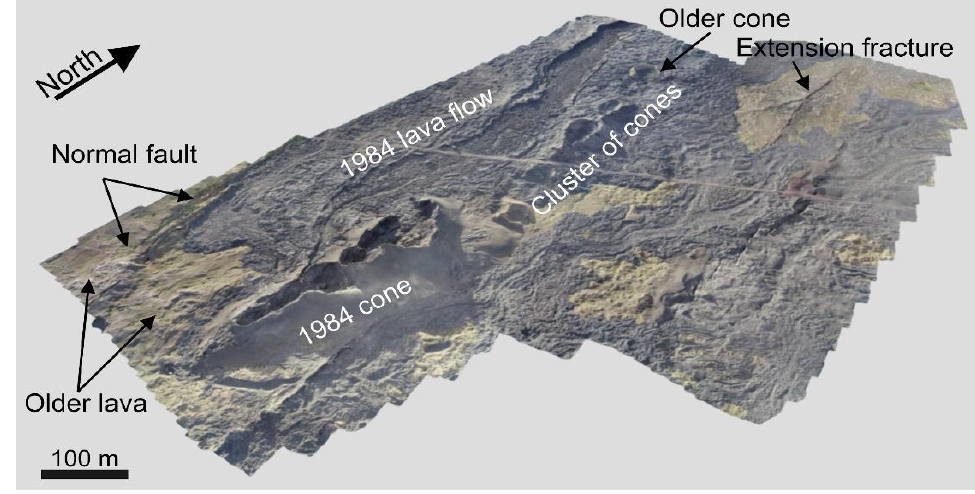
Figure 3. 3D view of the virtual geosite of the Krafla eruption site; the scale is highlighted in the figure.